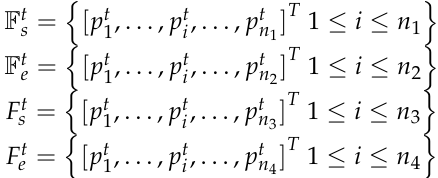
set contains the point cloud, as shown in Equation (4).